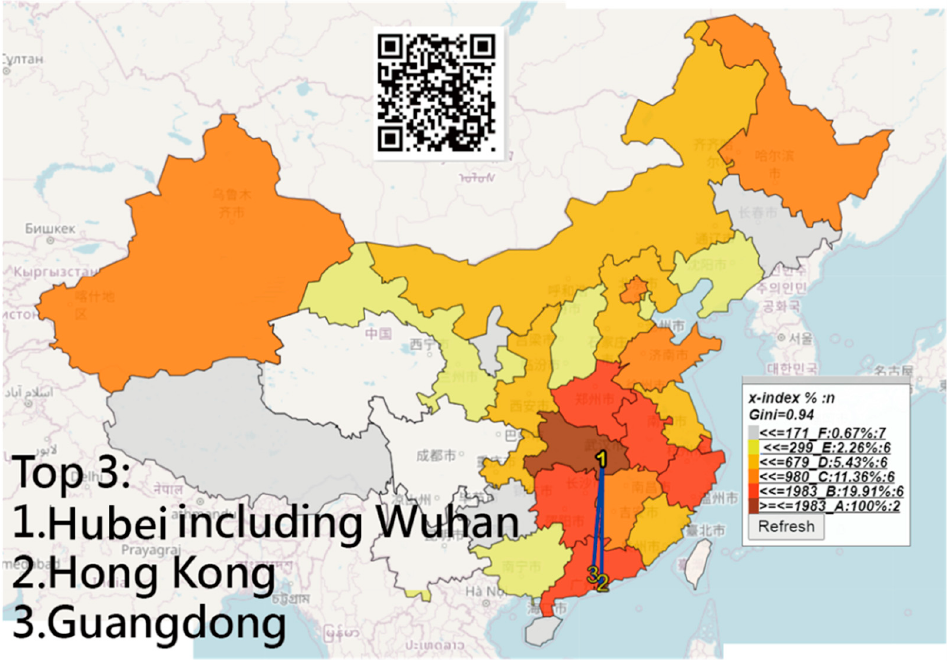
Figure 3. The top three regions with the most CNICs in China.